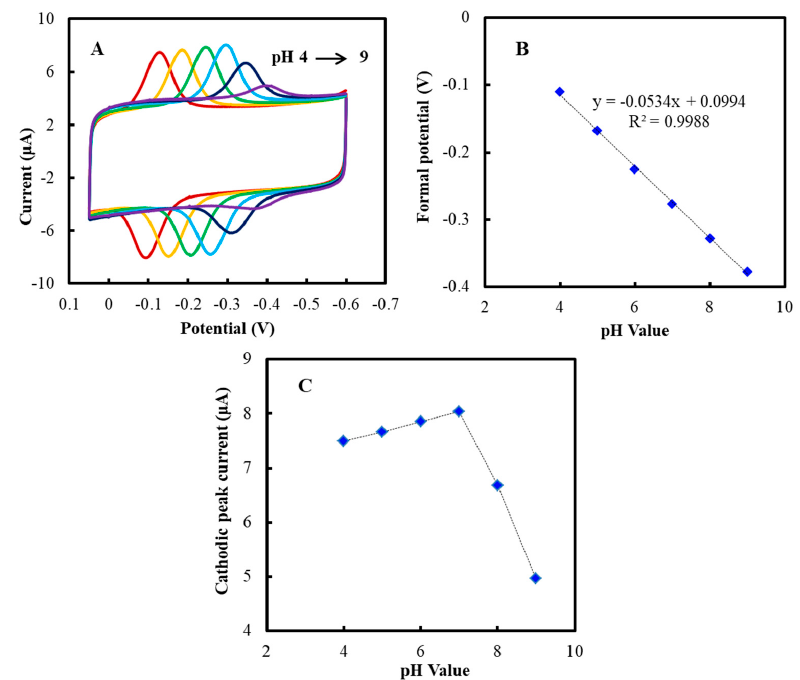
Figure 3. ( A ) CVs of the NF/GluOx/IL/mPEG-fMWCNTs modified GCE in PBS (50 mM) at different pH values (from left to right): 4.0, 5.0, 6.0, 7.0, 8.0, and 9.0, respectively. ( B ) Plot of formal potential ( E º ’ ) versus pH value. ( C ) Plot of cathodic peak current ( I pc ) versus pH value.